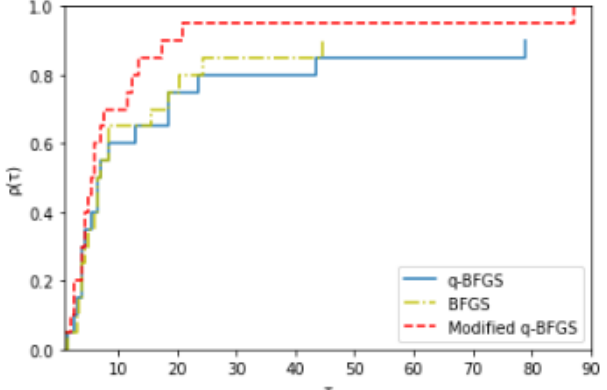
Figure 16. Performance Profile based on number of